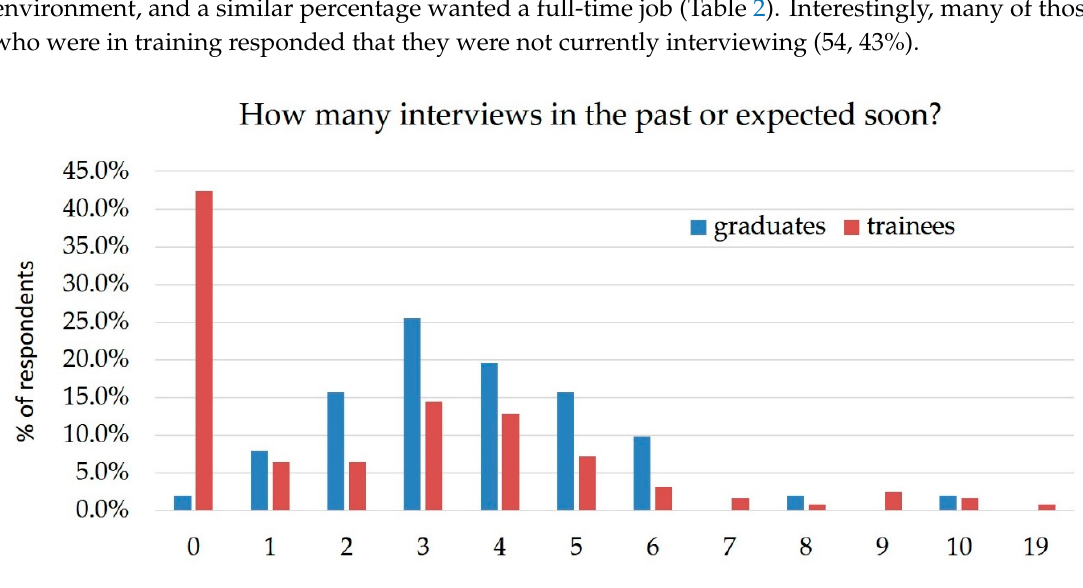
Figure 2. Reported numbers of interviews. Table 2. Job characteristics expressed as number (percentage). Respondents were able to select multiple regions.